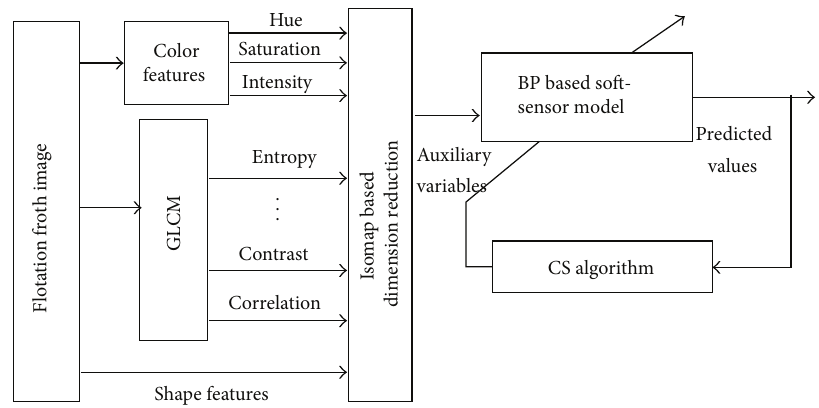
Figure 7: Structure of flotation soft-sensor